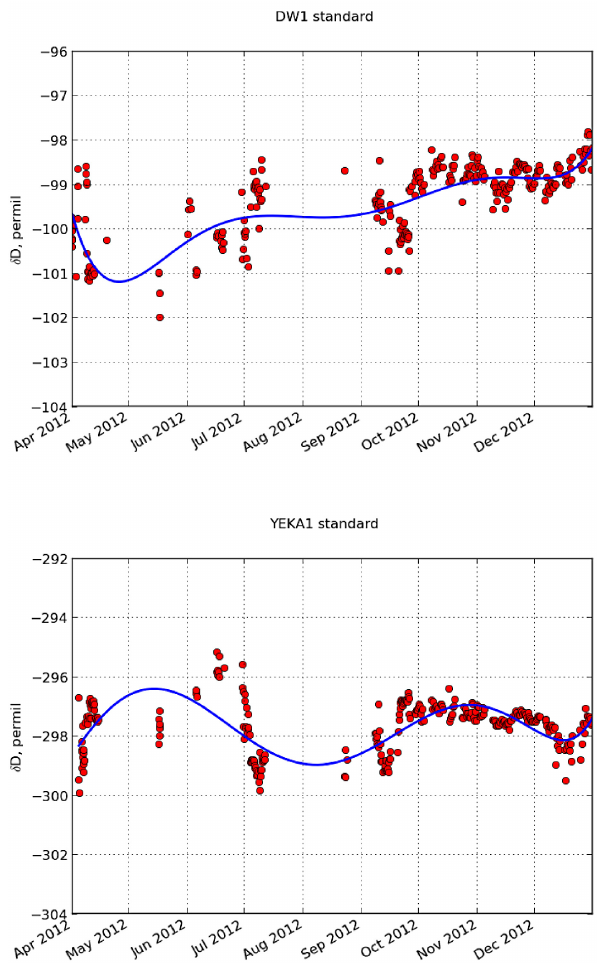
Figure 2. Variability of DW1 (top panel) and YEKA1 (bottom panel) standards measurements along with the polynomial fit used for calibration.